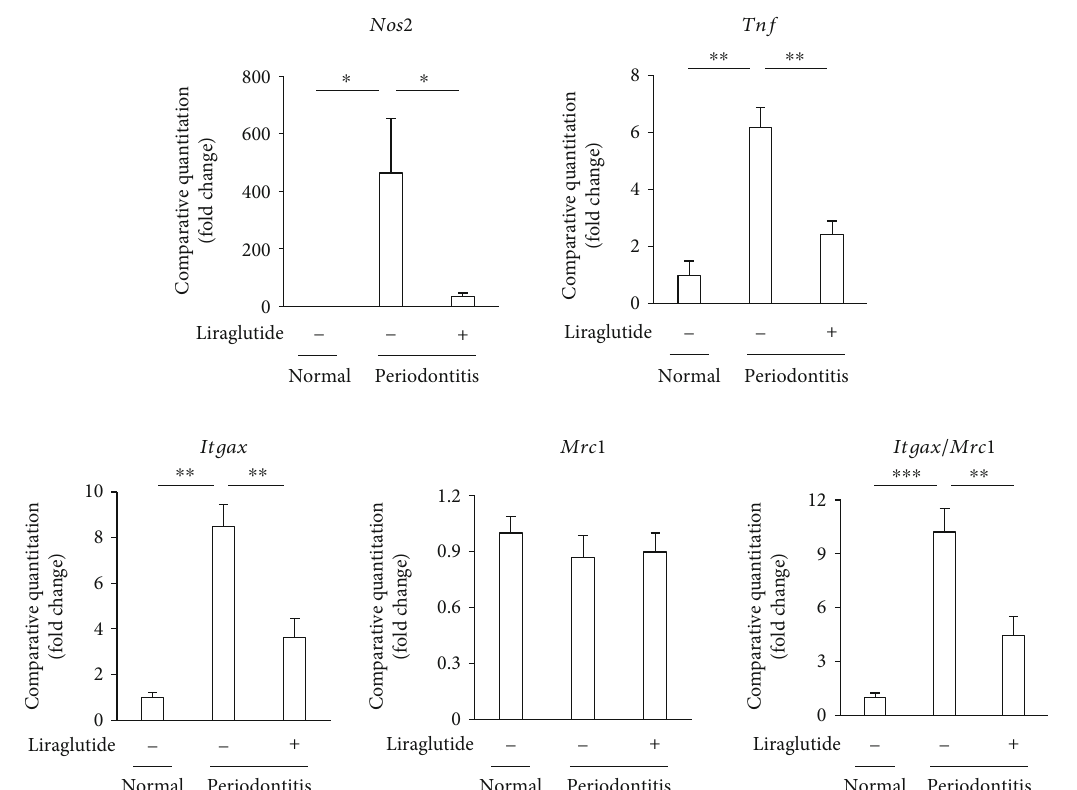
Figure 2: Liraglutide attenuated the gene expressions of in fl ammatory cytokines induced by periodontitis. Gene expressions of iNOS ( Nos2 ), TNF- α ( Tnf ), CD11c ( Itgax ), and CD206 ( Mrc1 ) were determined by quantitative real-time PCR. The results are expressed as the mean ± SEM ( n = 5 ). ∗ P < 0 : 05 , ∗∗ P < 0 : 01 , and ∗∗∗ P < 0 : 001